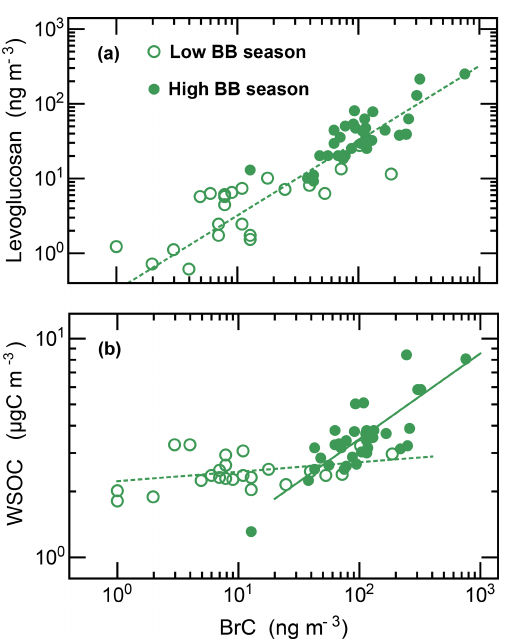
Figure 4. Scatter plot of the daily mean concentration of (a) lev- oglucosan and BrC, as well as (b) WSOC and BrC, measured at the Monserrate site. Filled circles are samples collected during the high BB seasons, and open circles were collected during low BB